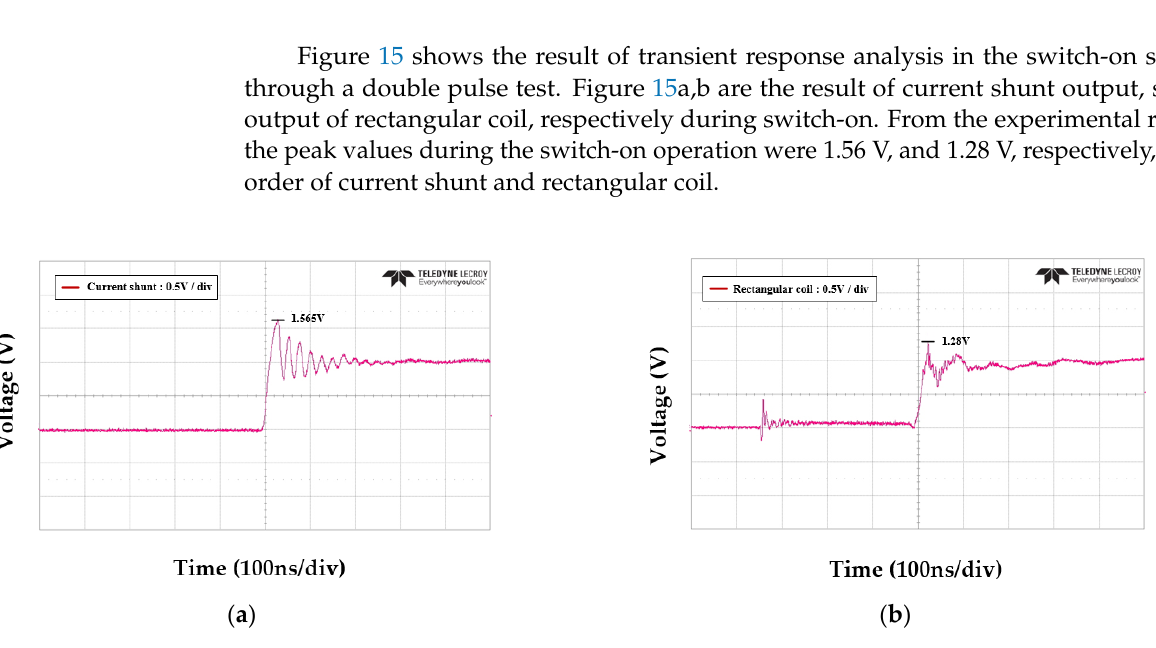
Figure 15. Integrator output waveforms during switch turn-on of pickup coils and shunt resistor sensor at DC link voltage V dc of 250 V: ( a ) switch-on condition and ( b ) switch-off condition.